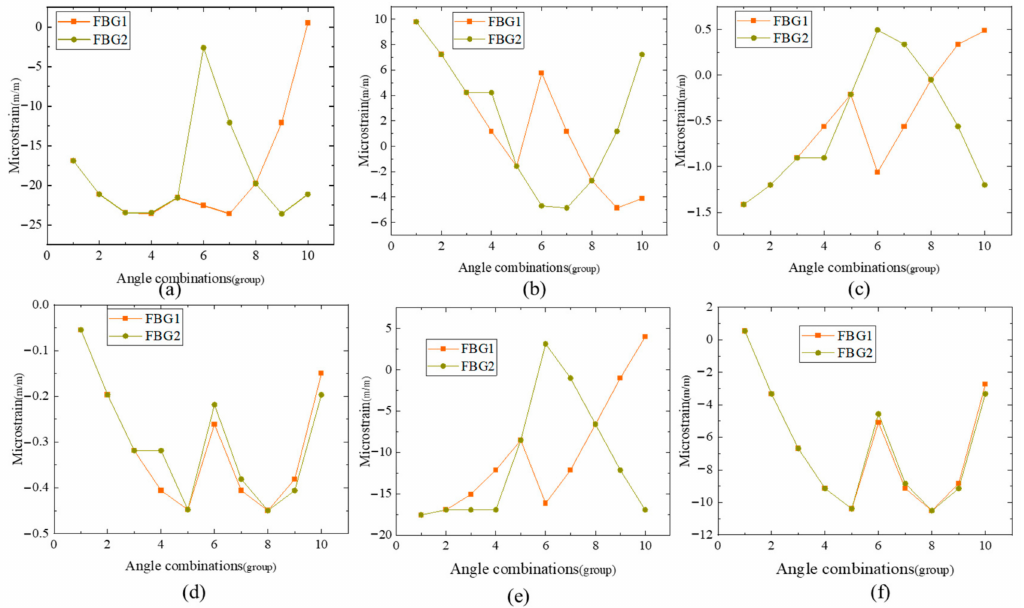
Figure 6. Double FBG strain variation diagram of measuring point 16: ( a ) Load loading mode 1; ( b ) Load loading mode 2; ( c ) Load loading mode 3; ( d ) Load loading mode 4; ( e ) Load loading mode 5; ( f ) Load loading mode